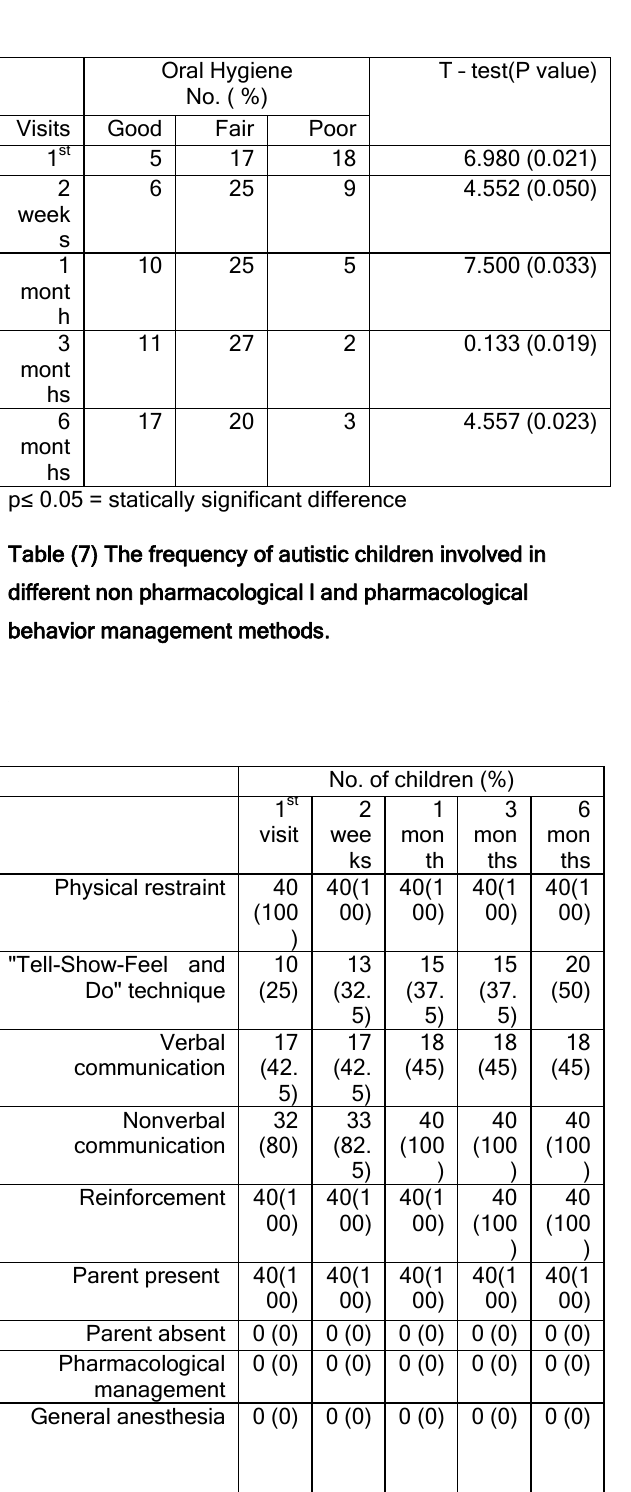
Table (6)The Oral hygiene was recorded according to debris index of the Simplified Oral Hygiene Index for autistic children in different dental visits.